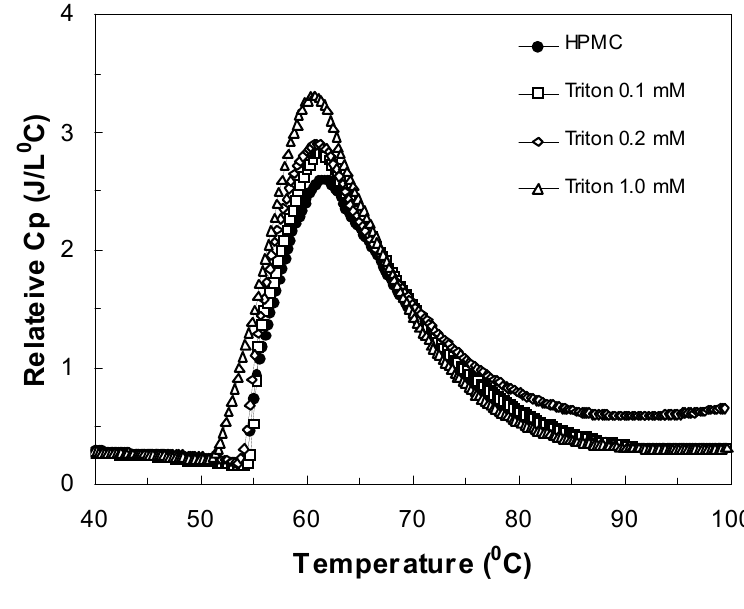
Figure 13. Relative heat capacity as a function of temperature for 1 wt% HPMC solutions with different concentrations of